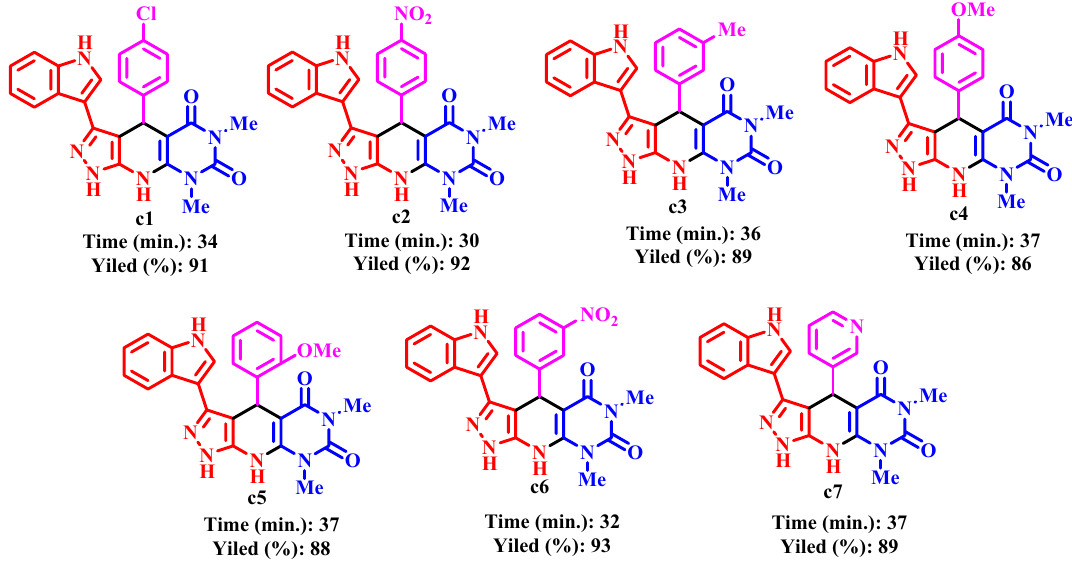
Table 3. Synthesis of pyrazolo[4 ′ ,3 ′ :5,6]pyrido[2,3- d ]pyrimidines using CQDs-N(CH 2 PO 3 H 2 ) 2 /SBA15 under solvent free condition.